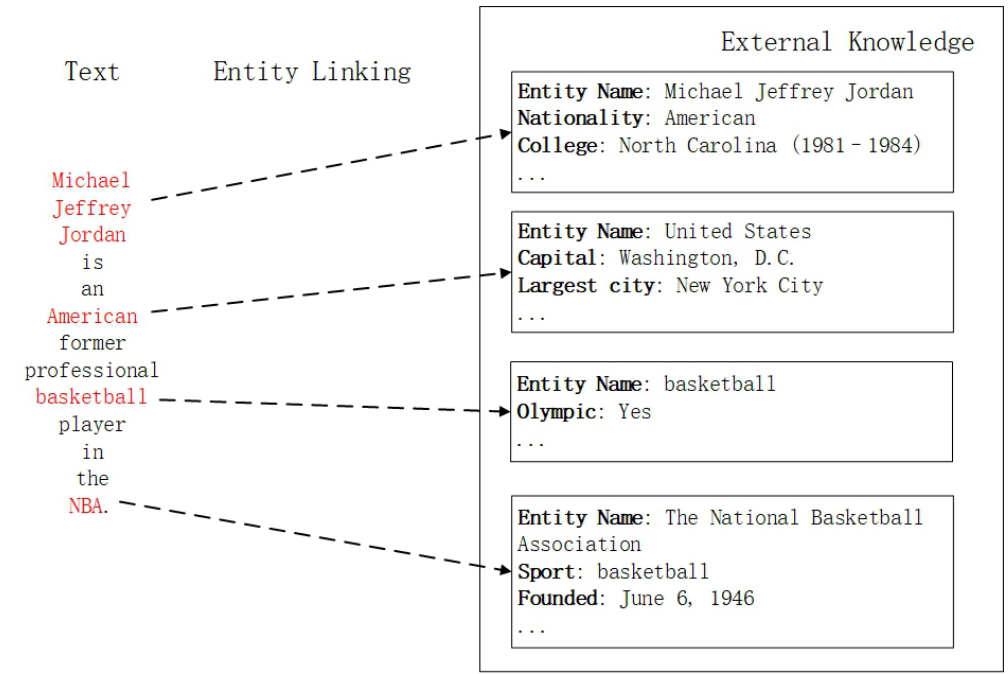
Figure 2. An example of entity